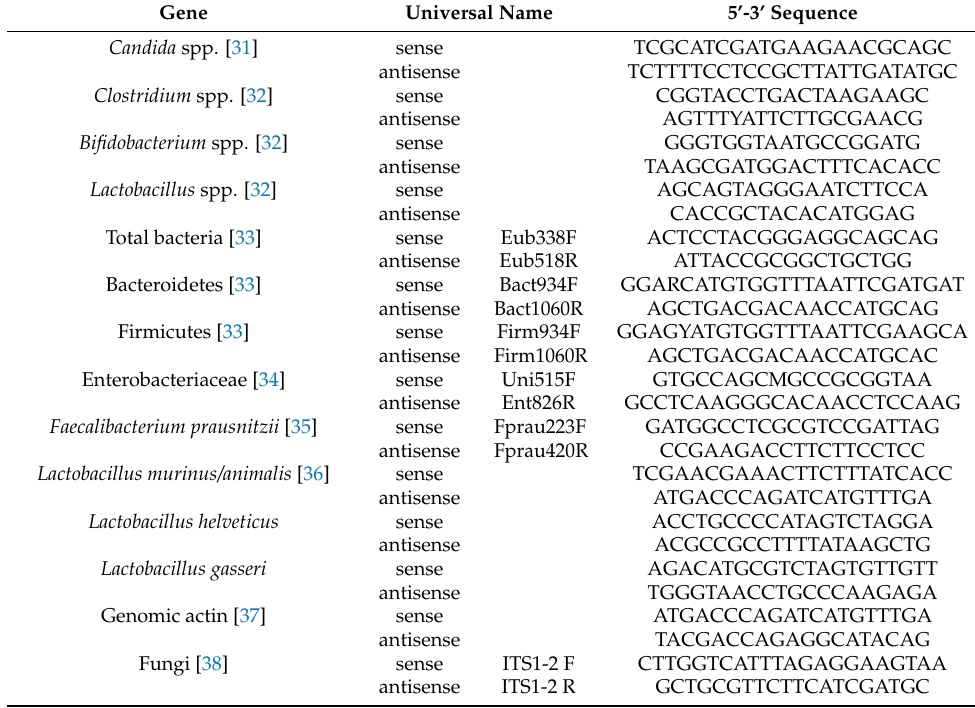
Table 1. Primers used for gut microbiota